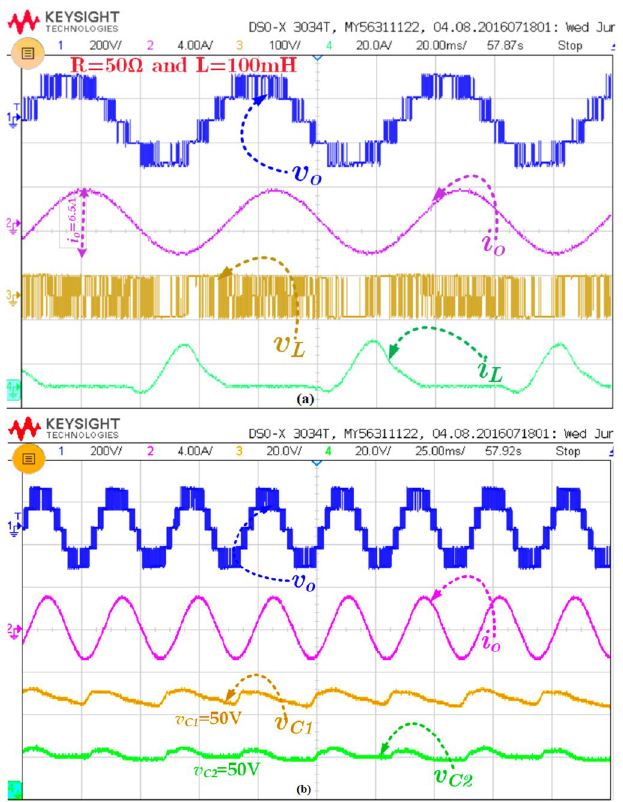
Figure 9. Experimental result of (a) v o , i o , v L , and i L for R = 50Ω and L = 100 mH and (b) v o , i o , v C1 , and v C2